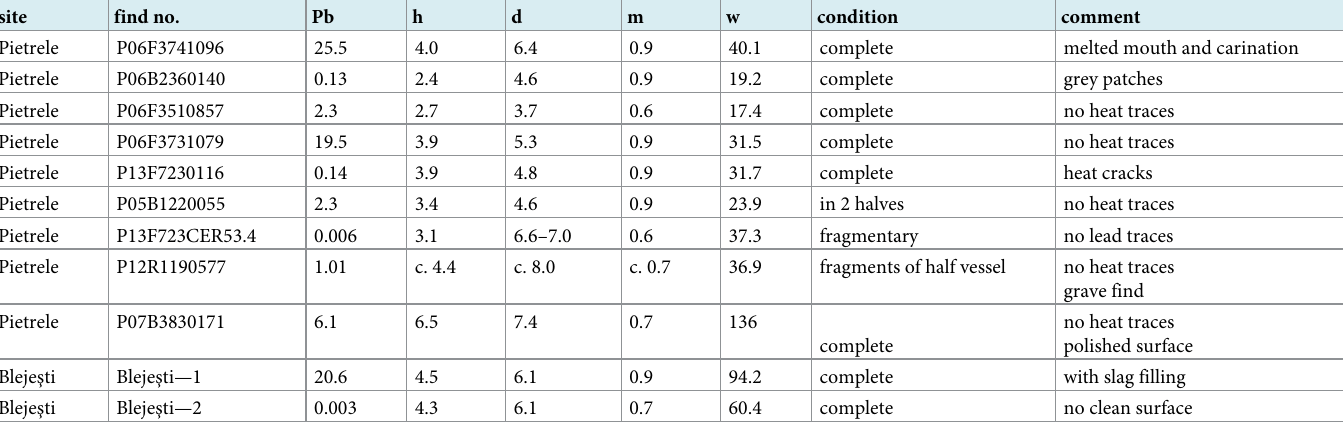
Table 1. Vessels from Pietrele and Bleje ş